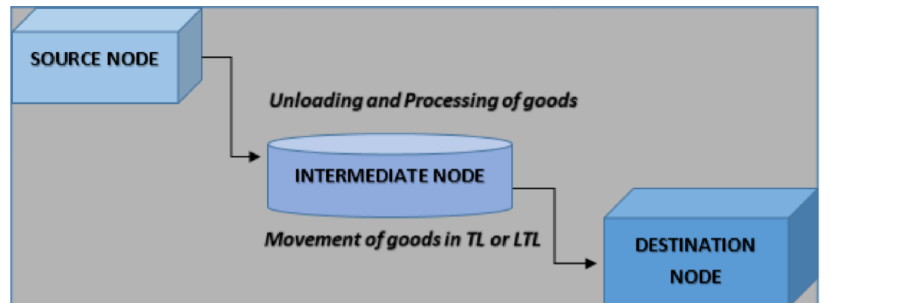
Figure 2. Two-Stage supply chain model for three